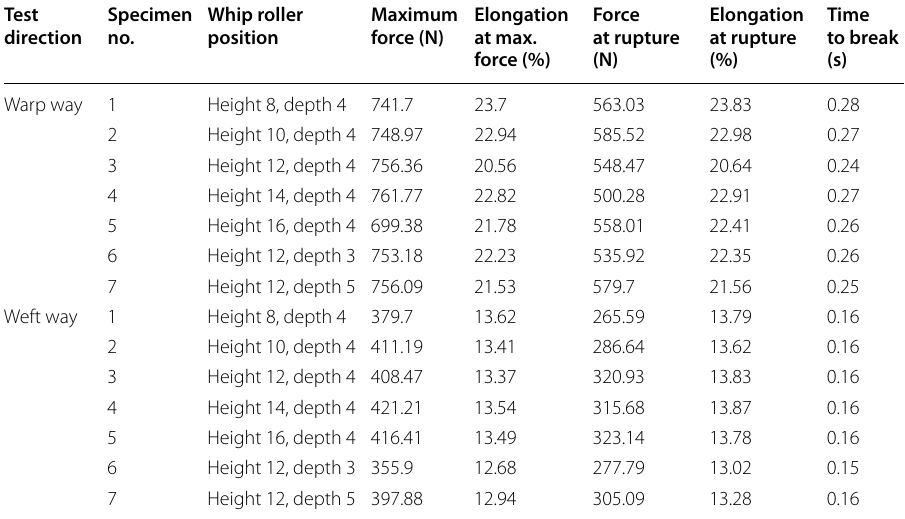
Table 5 Tensile strength test results in grab method for grey fabric in warp and weft way Test direction